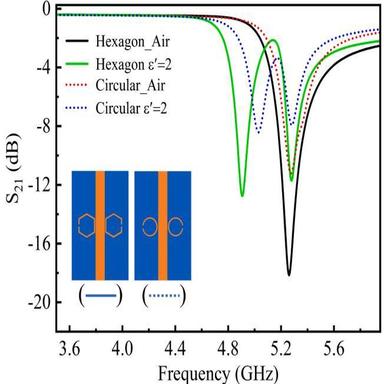
Comparison of proposed HSRR with Circular SRR sensor.